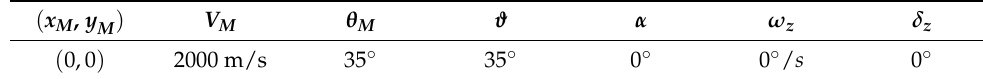
Table 1. Initial simulation values of the